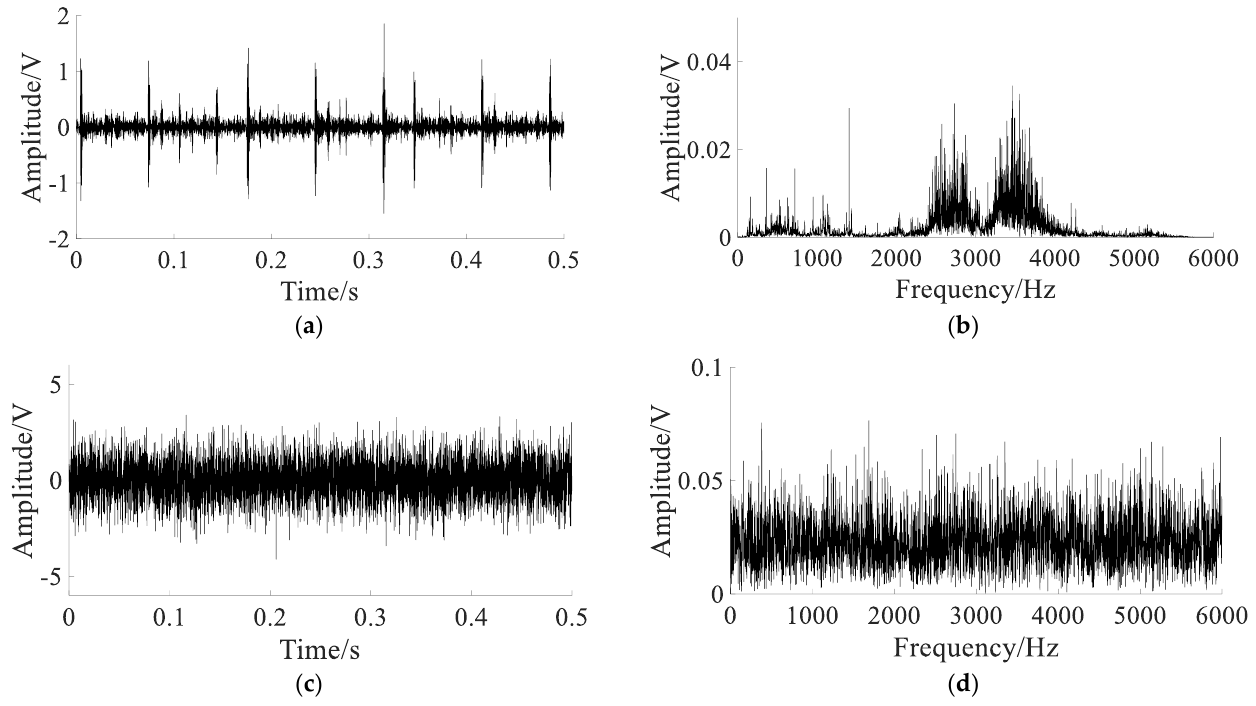
Figure 15. The bearing inner ring fault signals: ( a ) original signal; ( b ) spectrum of the original signal; ( c ) noisy signal; ( d ) spectrum of the noisy signal.